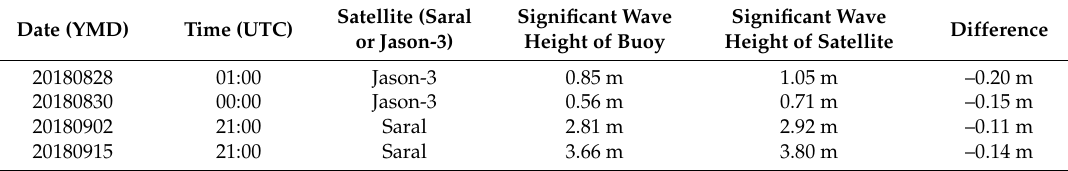
Table 4. Comparison of significant wave heights between the SBF7-1A GPS wave buoy and remote sensing satellites.